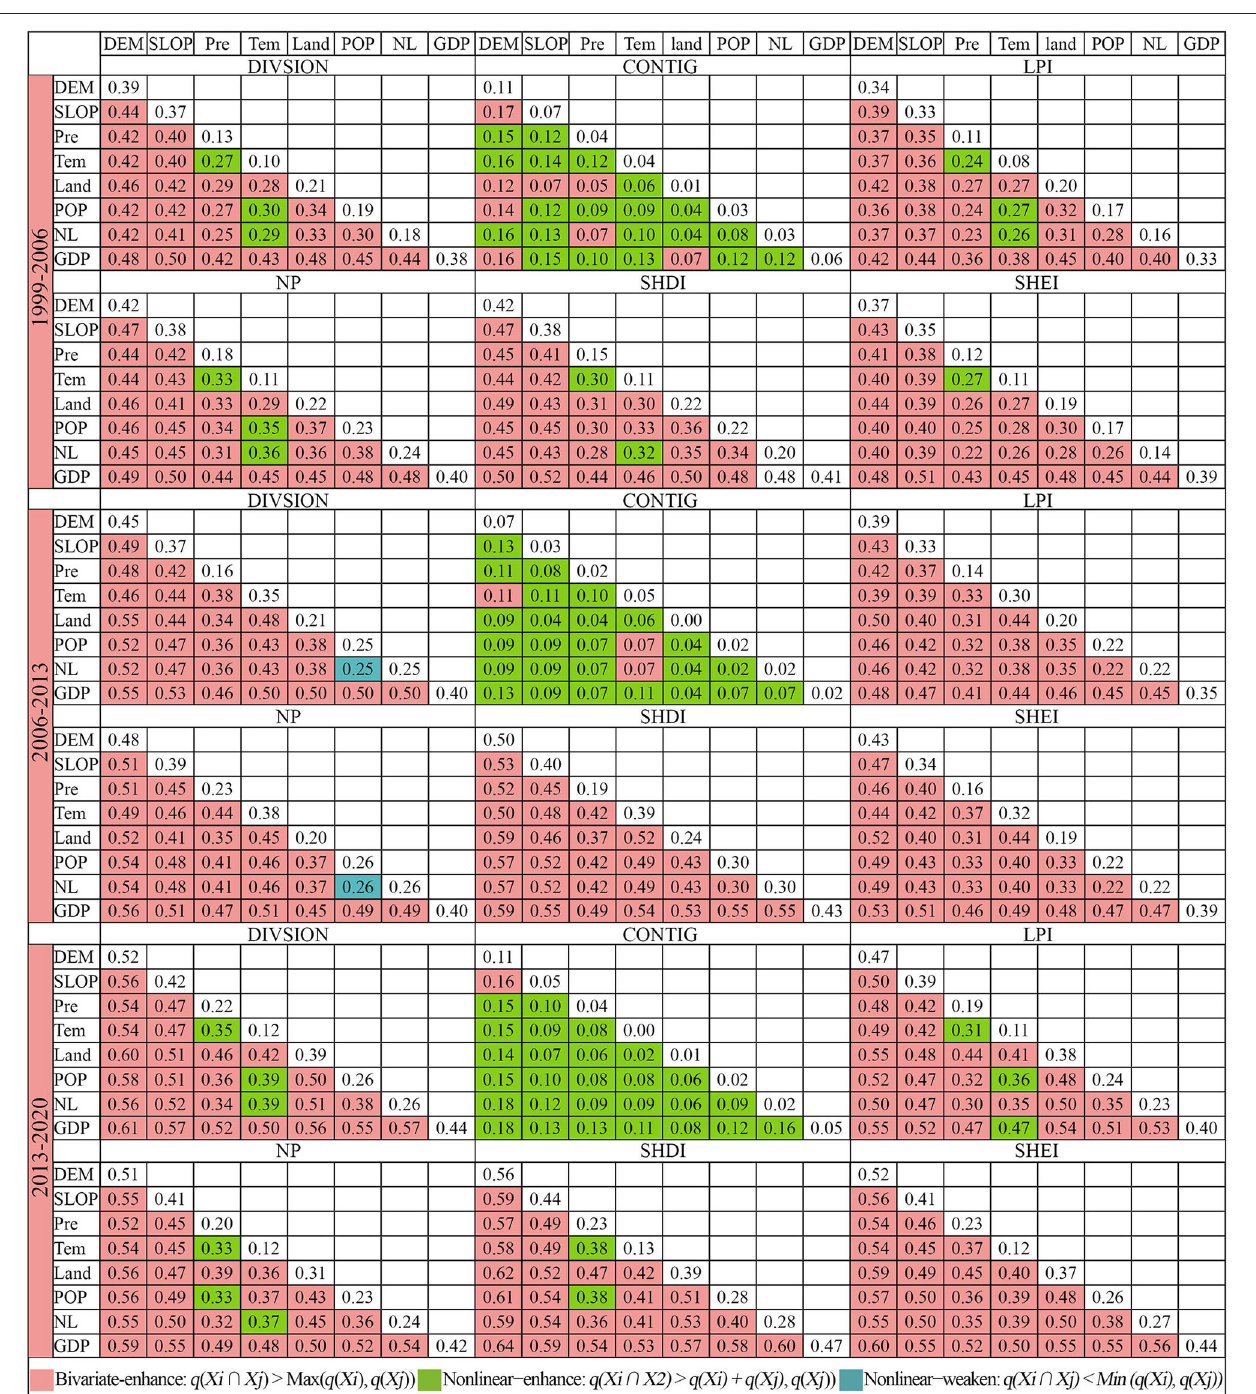
FIGURE 8 | Interaction of driving factors at the county